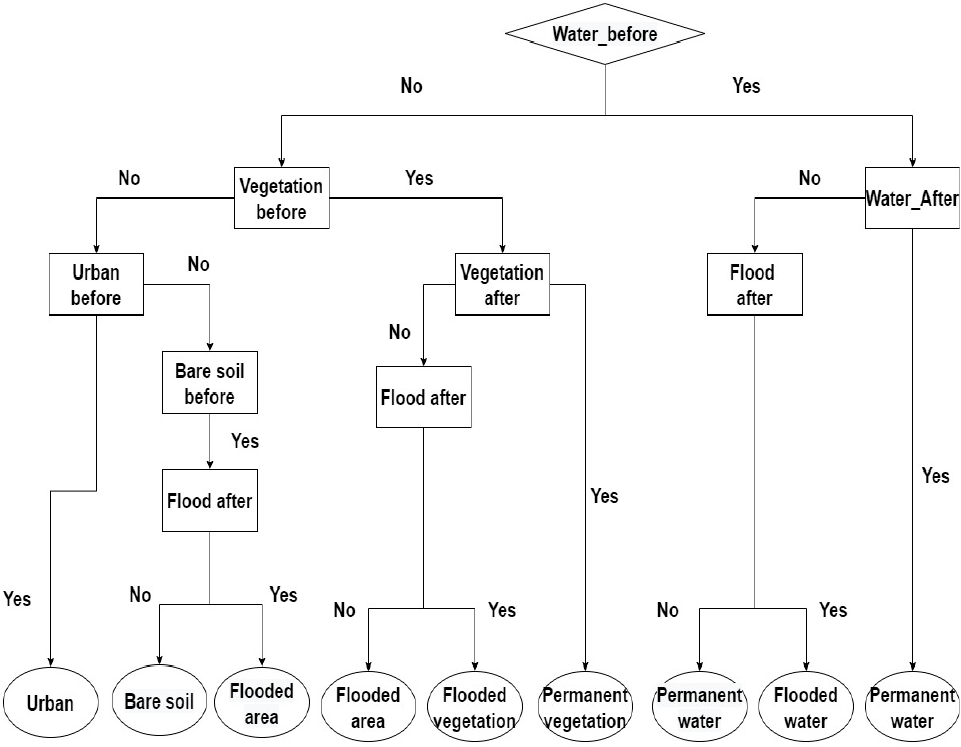
Figure 6. Change detection DT model for flooded areas mapping. The mother node is in the rhombus; the decision nodes are in the rectangles; the final classes are in the ovals.